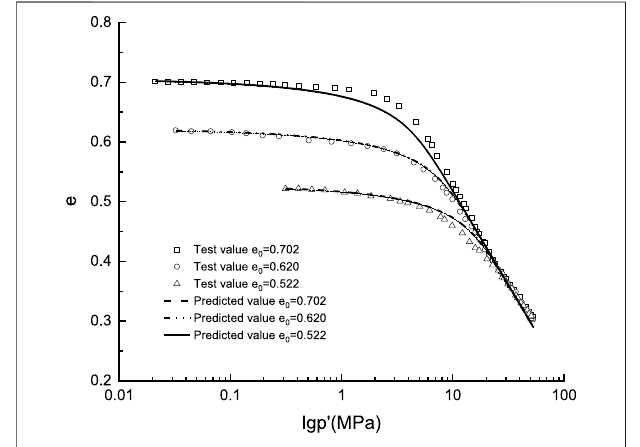
FIGURE 1 | Isotropic compression test and simulation results of loose, medium dense and dense Cambria sandy